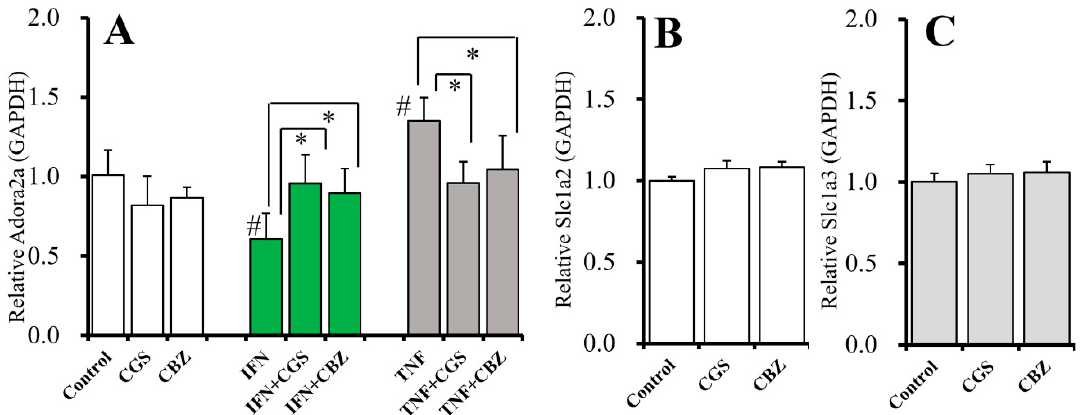
Figure 9. Interaction between chronic administration of IFN γ , TNF α , CGS21680, and CBZ on mRNA expression of A2AR ( Adora2a ) and astroglial glutamate transporters ( Slc1a2 and Slc1a3 ). ( A ) E ff ects of chronic administration of IFN γ (100 IU / mL), TNF α (100 IU / mL), CGS21680 (10 nM), and CBZ (20 µ M) on Adora2a expression in astrocytes. ( B , C ) E ff ects of chronic administration of CGS21680 (10 nM) and CBZ (20 µ M) on expression of Slc1a2 and Slc1a3 in astrocytes, respectively. Ordinates indicate the relative mRNA expression to GAPDH ( N = 6). * p < 0.05 relative to non CGS21680 or CBZ and # p < 0.05 relative to control by two-way ANOVA with Tukey’s post hoc test.